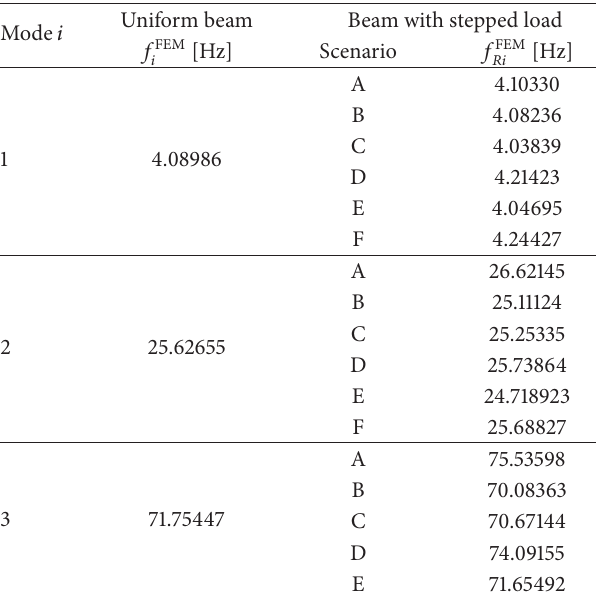
Table 5: Natural frequencies found by FEA for large affected region scenarios.